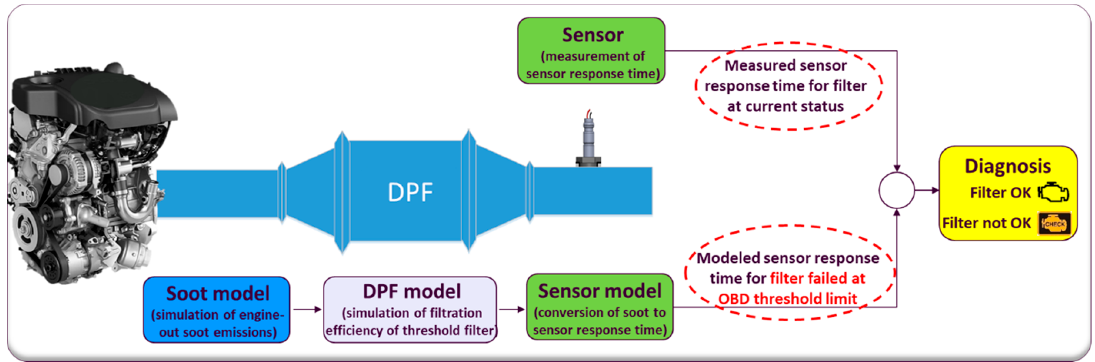
Figure 6. Overview of the OBD model developed in Matlab Simulink© .